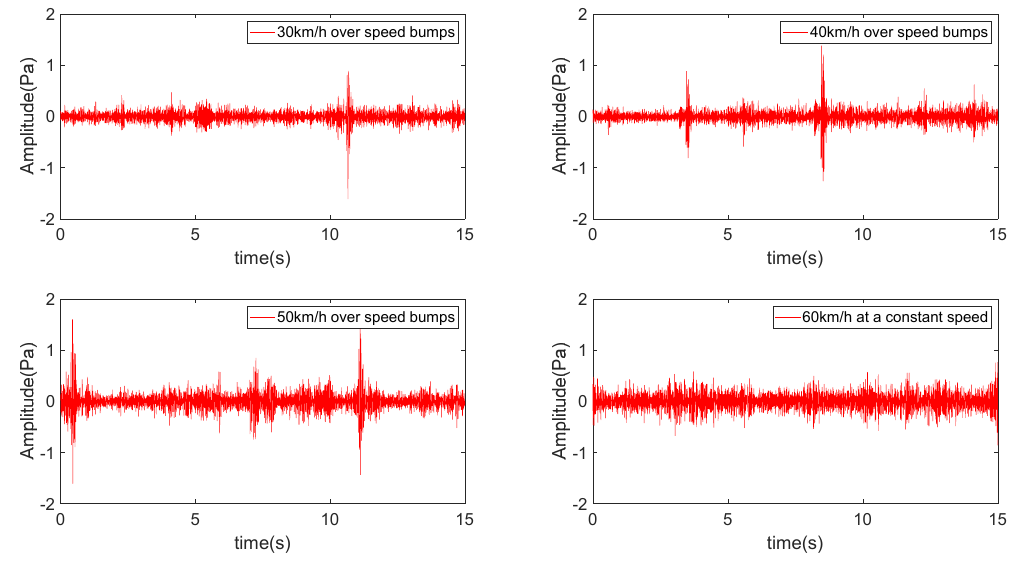
Figure 10. Vehicle noise acquisition location and layout.